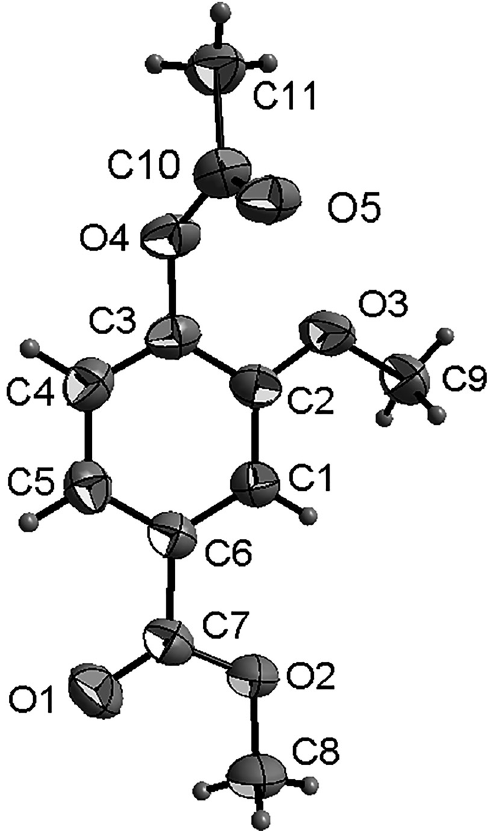
Table  : Data collection and